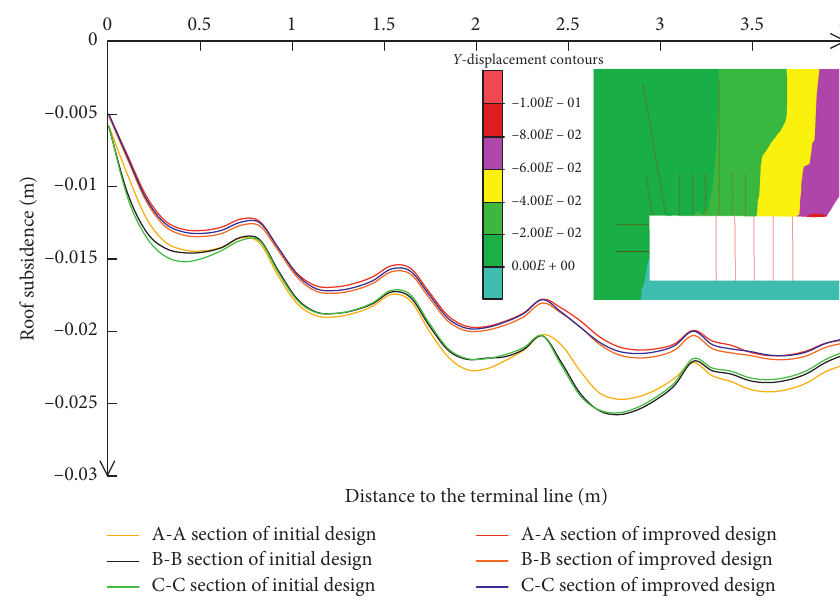
Figure 20: Roof subsidence curves of each section in the two support